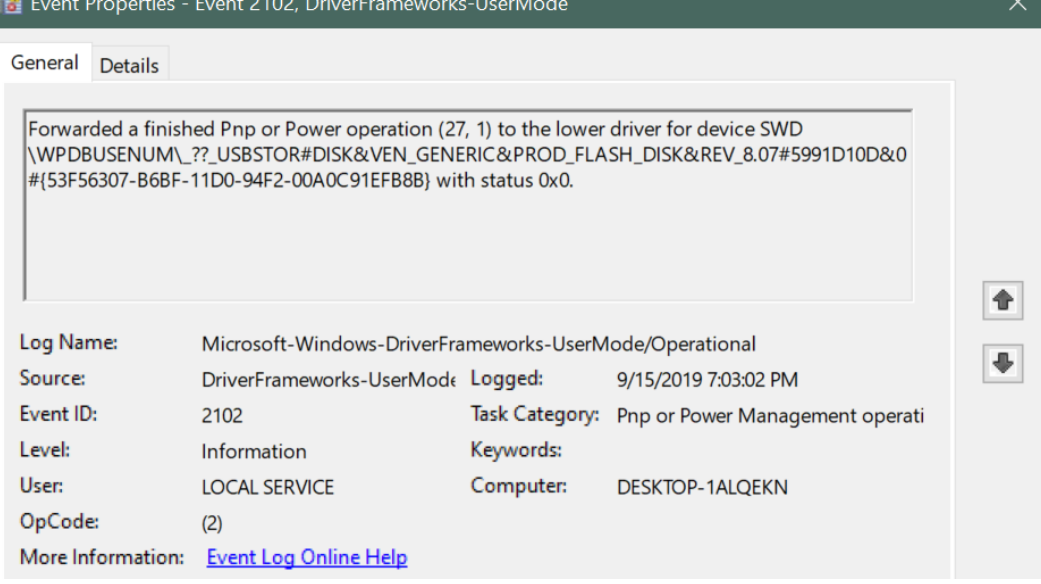
Figure 8. Event ID 2102 for generic USB